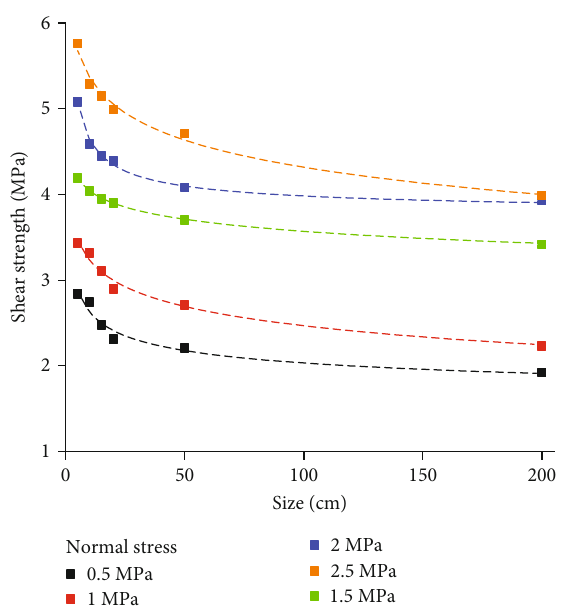
Figure 9: Relationship between model size and shear strength of models under di ff erent normal stress.